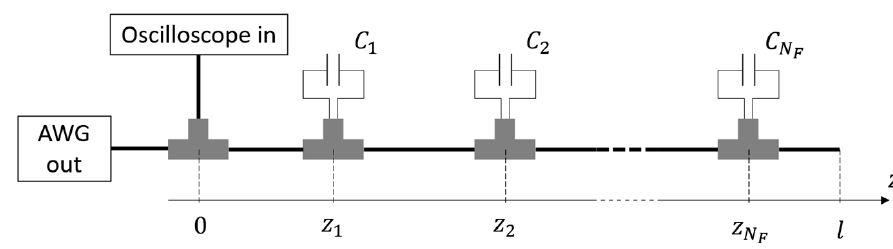
Figure 1. Representation of the measurement setup. Time-domain reflectometry (TDR) was applied to a cable containing N F parallel faults to estimate the N F pairs of values z i , C i .